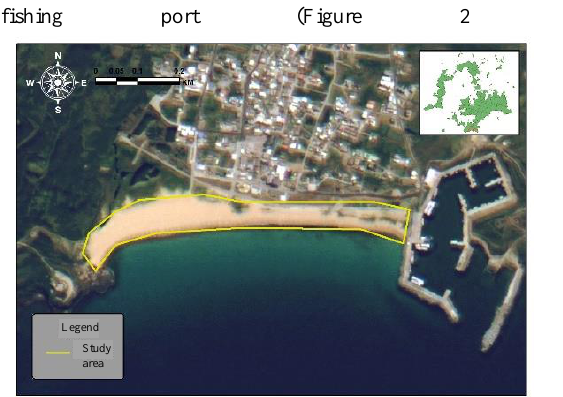
Figure 1. The location of study area